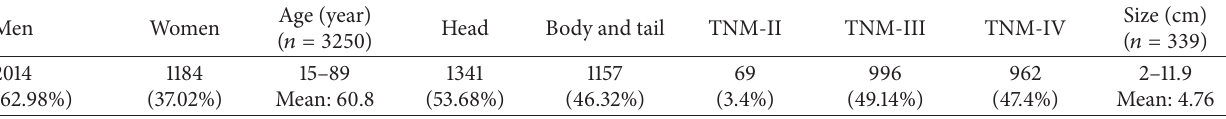
Table 1: Statistics of advanced pancreatic cancer patients treated with HIFU or in conjunction with chemotherapy or radiotherapy. Men